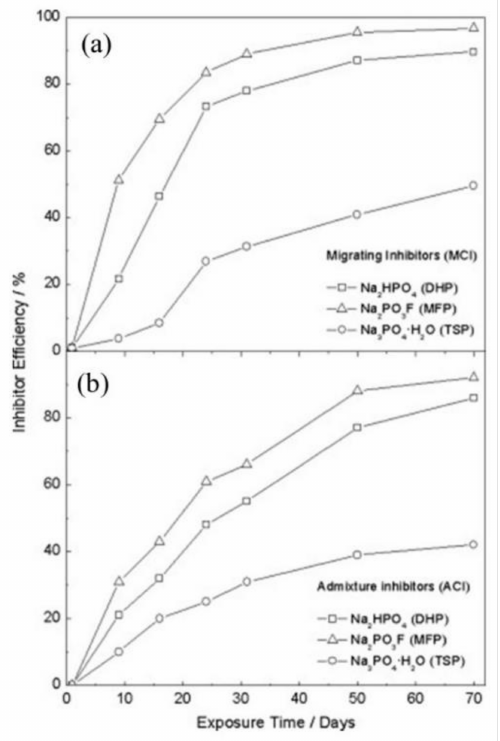
Figure 20. Inhibitor efficiency versus time for steel in the presence of: ( a ) migrating corrosion inhibitor (MCI), and ( b ) admixture corrosion inhibitor (ACI) [42]. Reproduced with permission from Bastidas, D.M. et al., Constr. Build. Mater.; published by Elsevier, 2010.